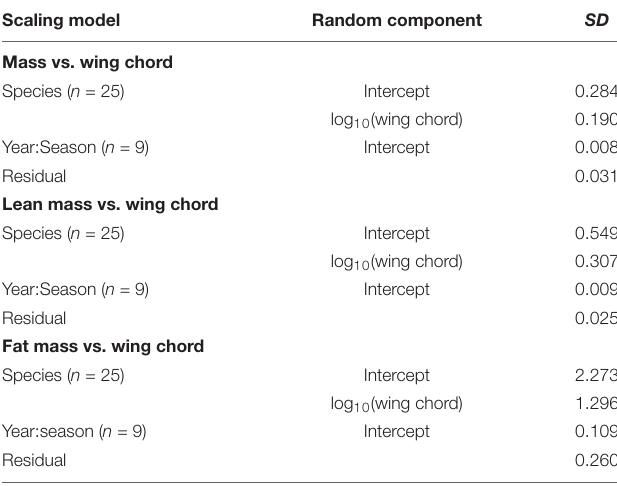
TABLE 2 | Random effects in scaling relationships with structural size for songbirds stopping over at Long Point, Ontario. Scaling model